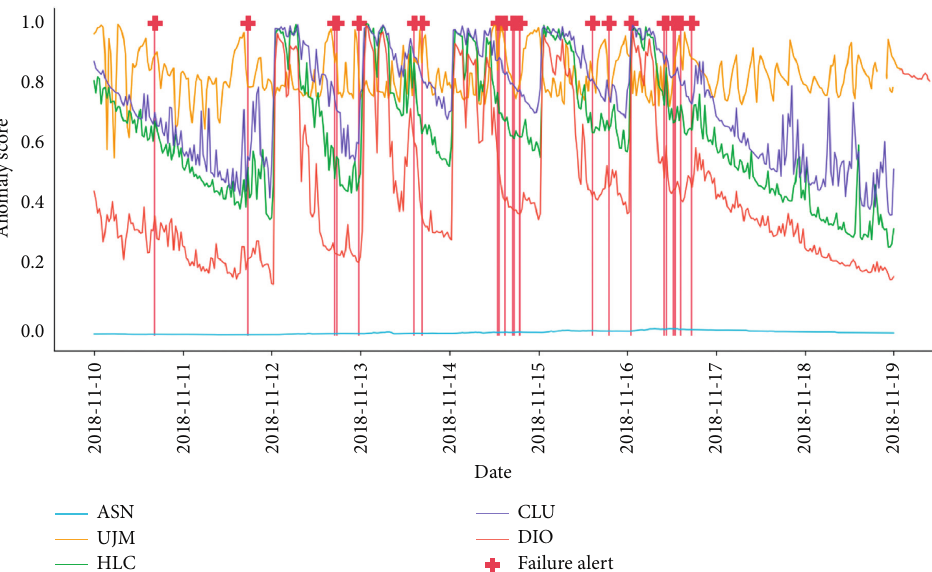
Figure 3: Results from EXPoSE and all alerts of Elasticsearch. Table 4: Correlations between the anomaly scores generated by Table 3: Correlations between the five attributes of one node. ASN UJM CLU HLC DIO ASN